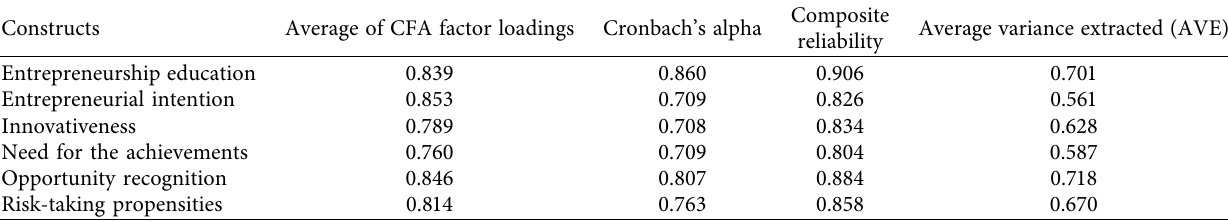
Table 2: Reliability and convergent validity.